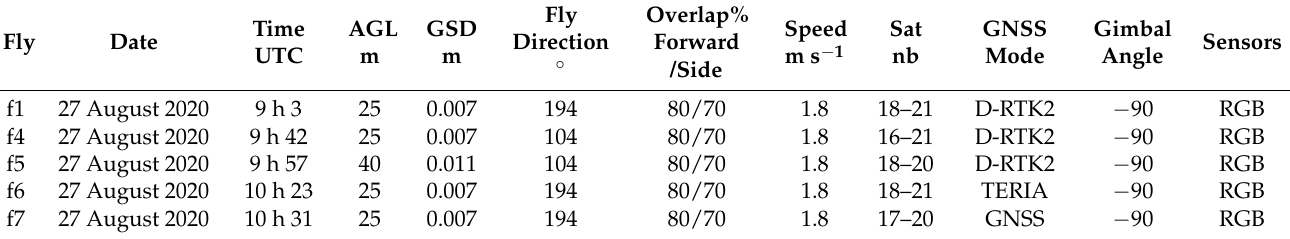
Table 2. Flight parameters used for the study.